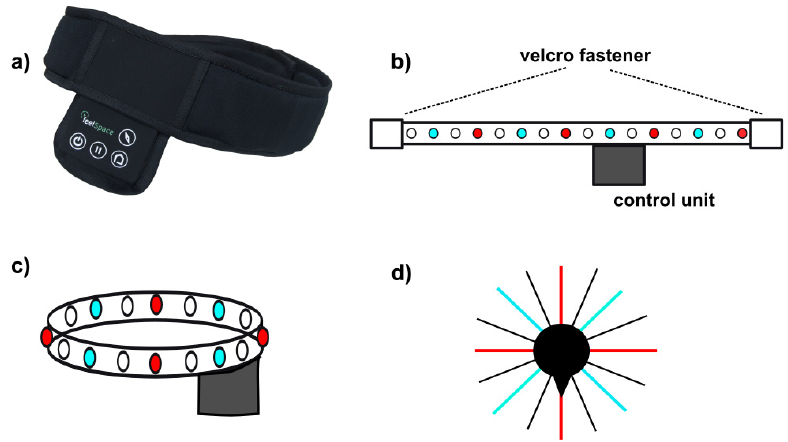
Figure 1. The feelSpace belt [37]: ( a ) picture of the belt, ( b ) layout when stretched open, ( c ) vibration motor layout around the waist, vibration motors on 90° in red, on 45° in light blue, control unit marked in grey, ( d ) vibration layout around the body axis, walking direction is marked with the black triangle.